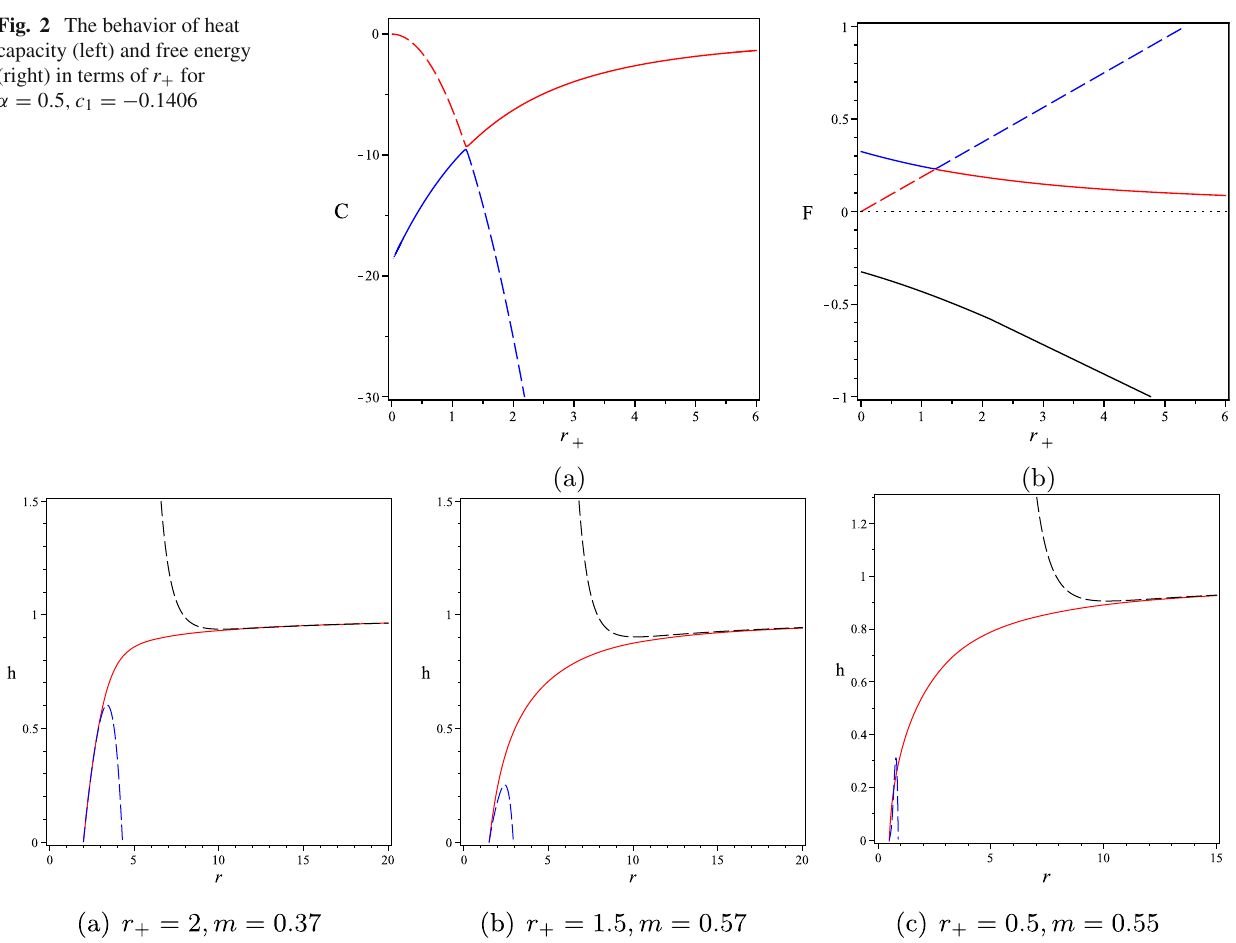
Fig. 3 The plots of metric for α = 0 . 5 , c 1 = − 0 . 1406. The red solid line is the full continued-fraction solution, the blue dashed line is the near-horizon solution and black dashed line is the large- r